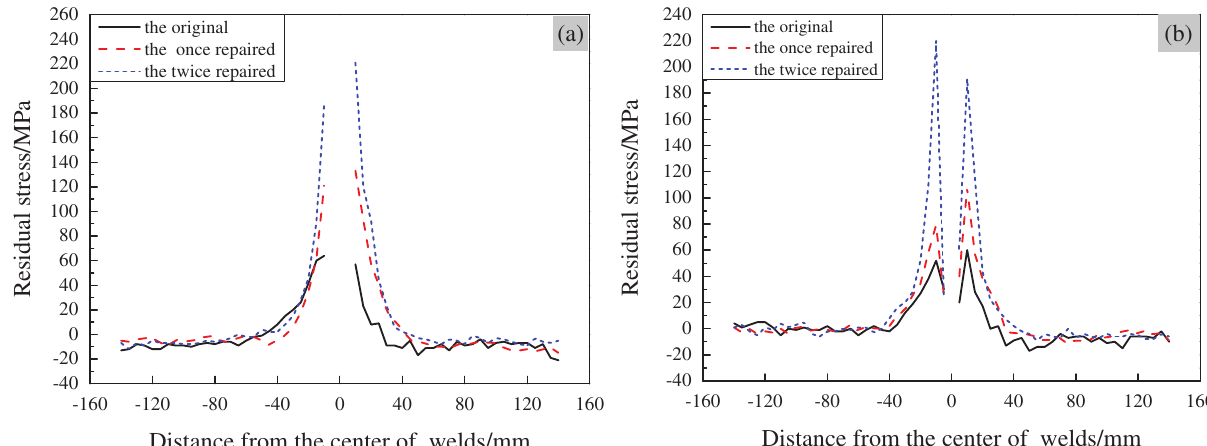
Figure 7: Residual stress curve: (a) top surface of joint; (b) bottom surface of